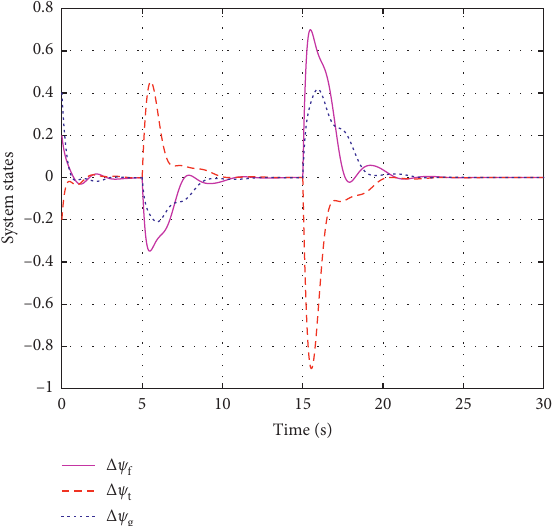
Figure 5: System states with the attack compensator.